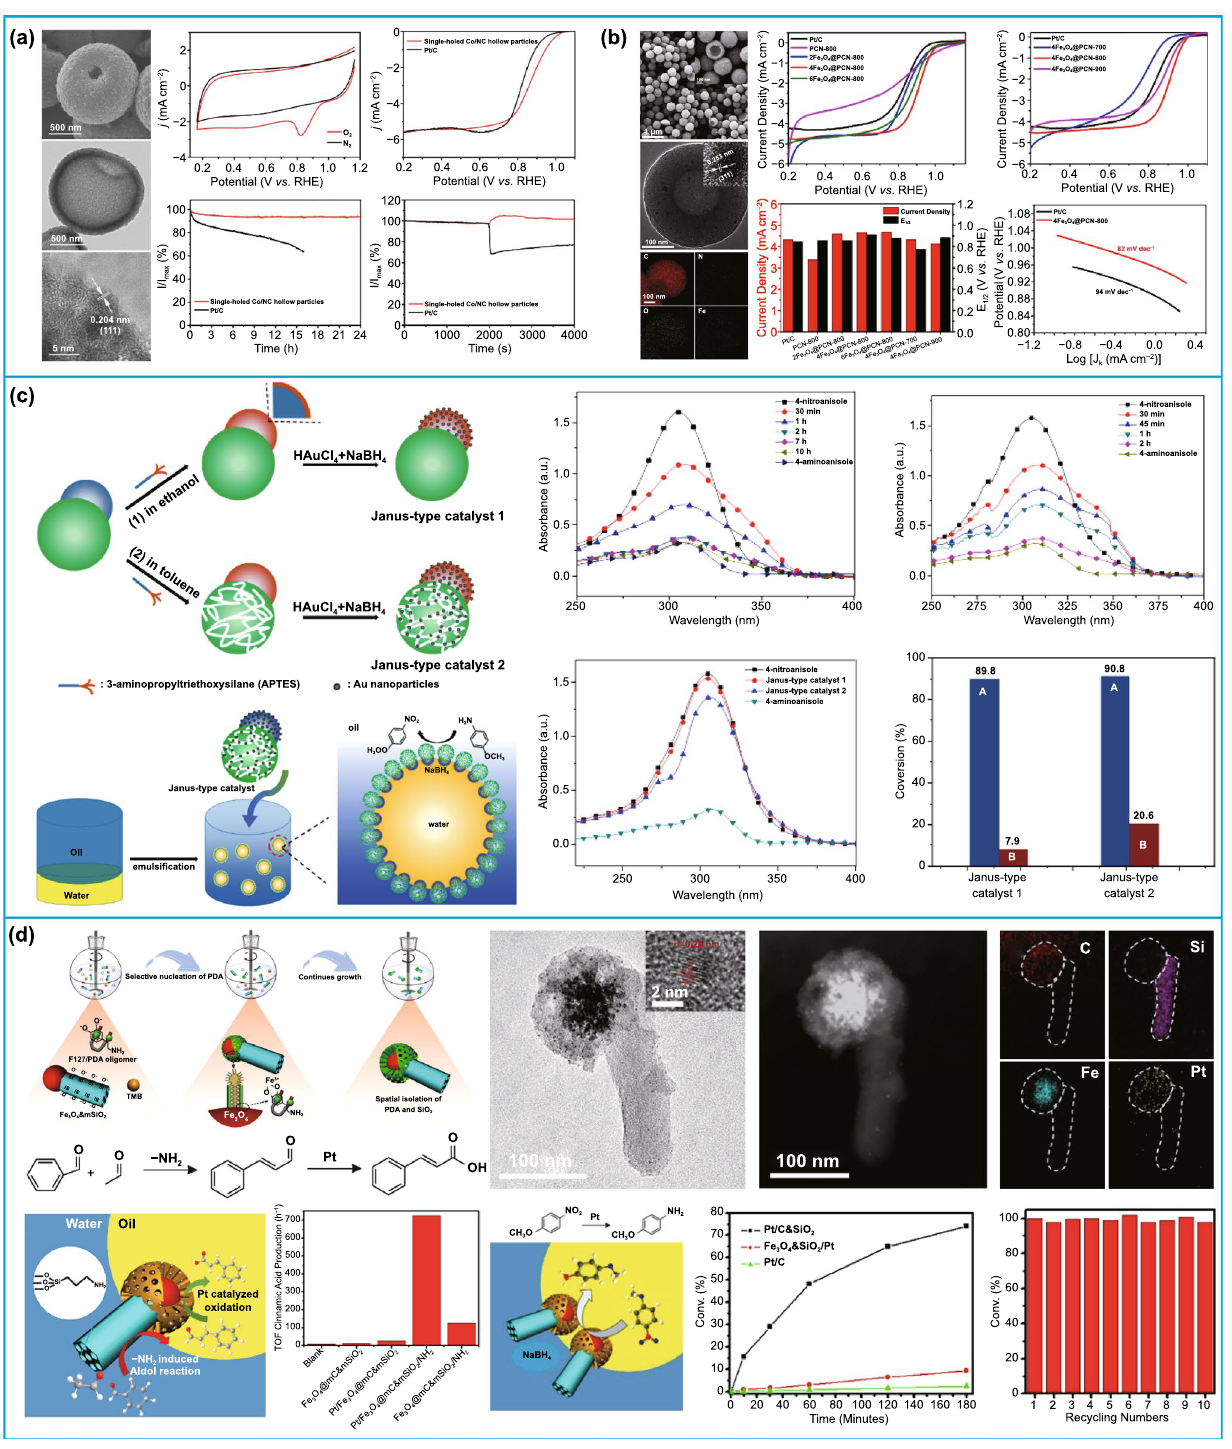
Fig. 12 Application of asymmetric structure in catalysis. a Single-hole cobalt-/N-doped carbon hollow particles for oxygen reduction reaction. Reproduced with permission from Ref. [36]. Copyright 2017, Wiley–VCH. b Fe-embedded porous nanobowls for ORR. Reproduced with per- mission from Ref. [140]. Copyright 2019, Elsevier B.V. c Application of the SiO 2 @PDVB/PS Janus particles in two-phase catalytic reaction. Reproduced with permission from Ref. [142]. Copyright 2017, Elsevier B.V. d Application of the spatial isolation silica–carbon Janus structure complex in two-phase catalytic reaction. Reproduced with permission from Ref. [125]. Copyright 2018, American Chemical